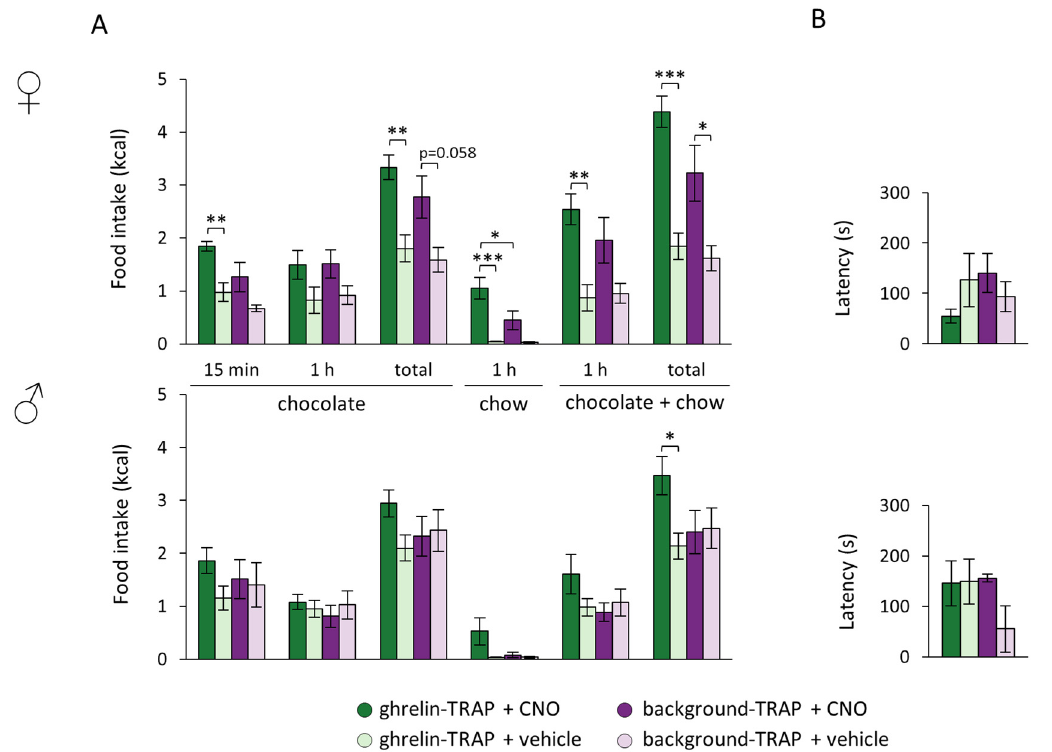
Figure 3. Ghrelin-responsive cells in the arcuate nucleus affected food choice in a sex-dimorphic fashion. Both the ghrelin-TRAPed (n = 13: males, n = 8; females, n = 5) and background-TRAPed groups (n = 8: males, n = 4; females, n = 4) were injected with clozapine-N-oxide (CNO) and vehicle in a cross-over design, and subjected to a chocolate search for 15 min, followed by a food choice paradigm in which they had access to both chocolate and regular chow for 1 h. ( A ) Chocolate intake (upon the 15 min behavioral test, at the end of the 1 h choice paradigm and total intake), 1 h chow intake and total energy intake (at the end of the 1 h choice paradigm and total intake) in both ghrelin-TRAPed and background-TRAPed females (upper panel) and males (lower panel). * p < 0.05, ** p < 0.01, *** p < 0.001; ( B ) Latency to discovering the chocolate treat in both ghrelin-TRAPed and background-TRAPed females (upper panel) and males (lower panel). Error bars represent ± SEM in all figures.